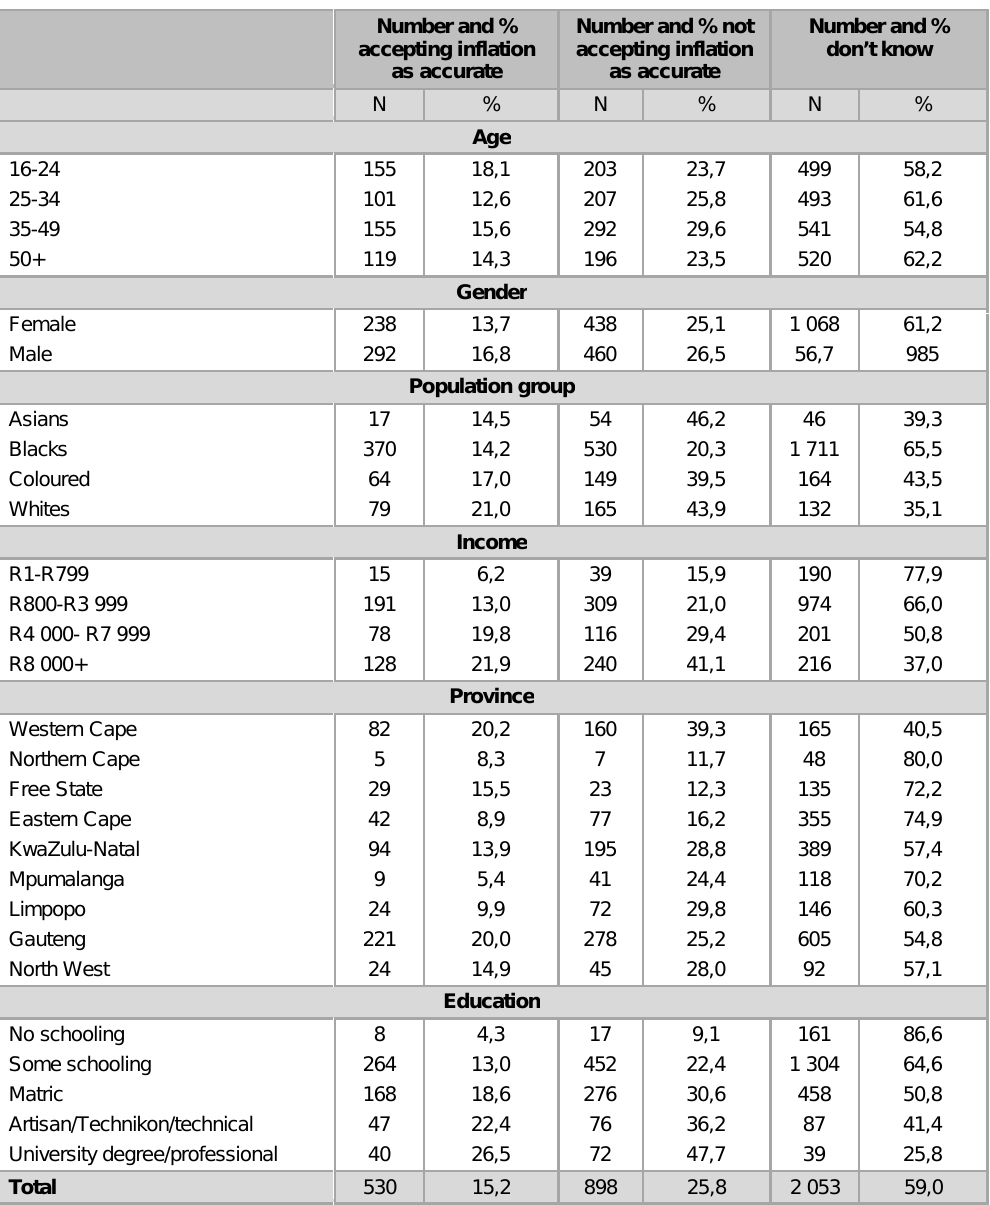
Responses about inflation credibility according to age, gender, population group and the total, 4 th quarter